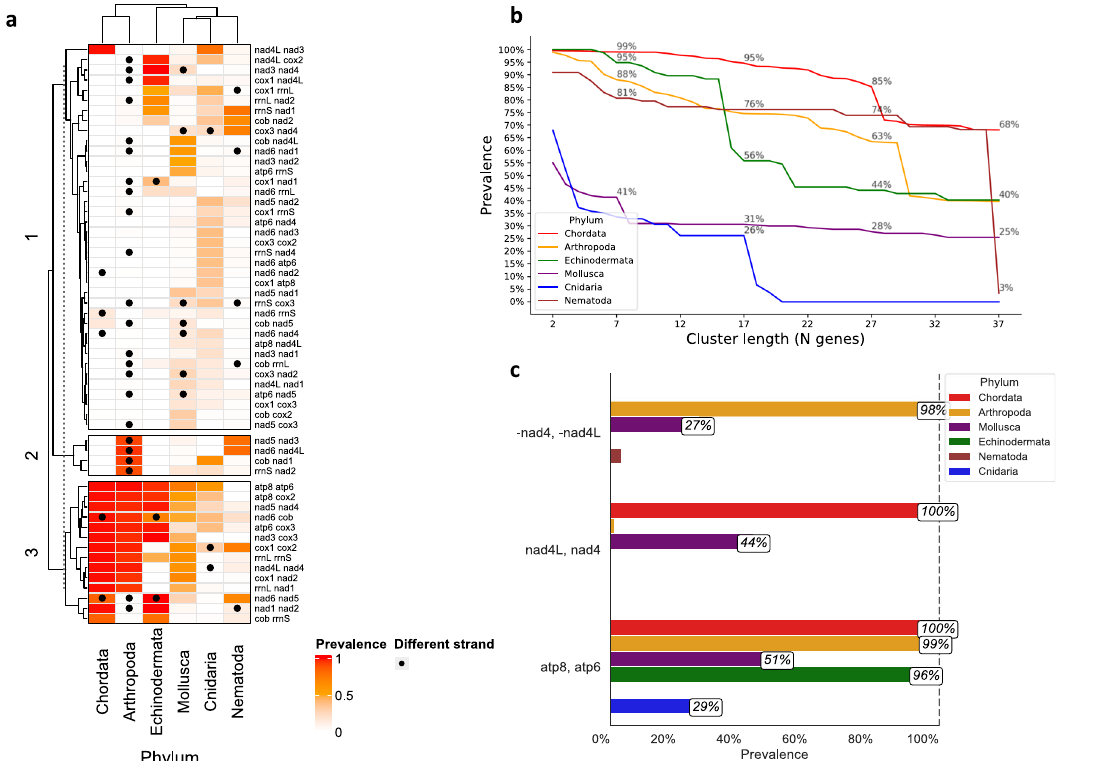
Fig. 3 Long gene orders are conserved only within taxa, whereas gene couples are highly conserved across metazoans. a Heatmap showing the pairwise neighboring prevalence (in the percentage of all observed gene couples by phylum). Black dots indicate that the indicated two genes are in opposing strands. Rows and columns are hierarchically clustered based on Euclidean distance. b The prevalence of the most common gene cluster within each phylum for every cluster length (2 – 37 genes). c The per-phylum prevalence (in percentage) of the gene couples ATP8 ATP6 , ND4L ND4 (forward strand), and -ND4 -ND4L (reverse strand). See also Supplementary Data S7 and Supplementary Data S8 for raw data (https:// fi gshare.com/projects/Shtolz_2022_